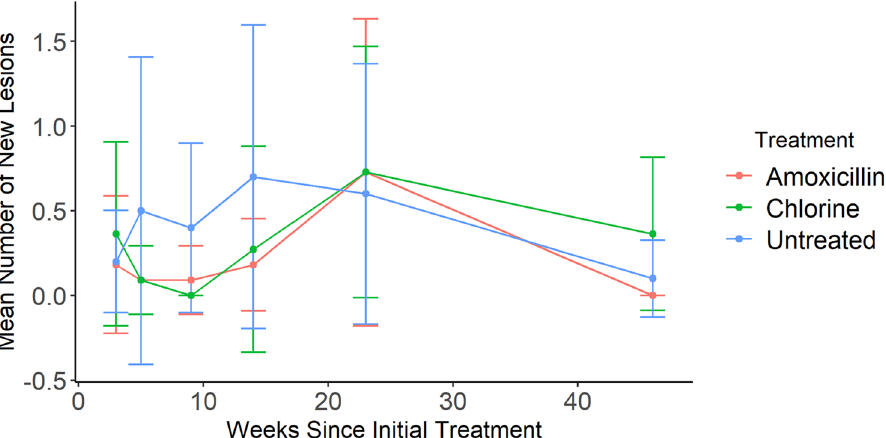
Figure 6. Mean number of new SCTLD lesions developed on a colony since the previous monitoring event, beginning at 3 weeks and ending at 46 weeks, grouped by treatment. Amoxicillin refers to the Base 2B plus amoxicillin treatment, chlorine refers to the chlorinated epoxy treatment, and untreated refers to the SCTLD- affected controls. Bars represent 95% confidence